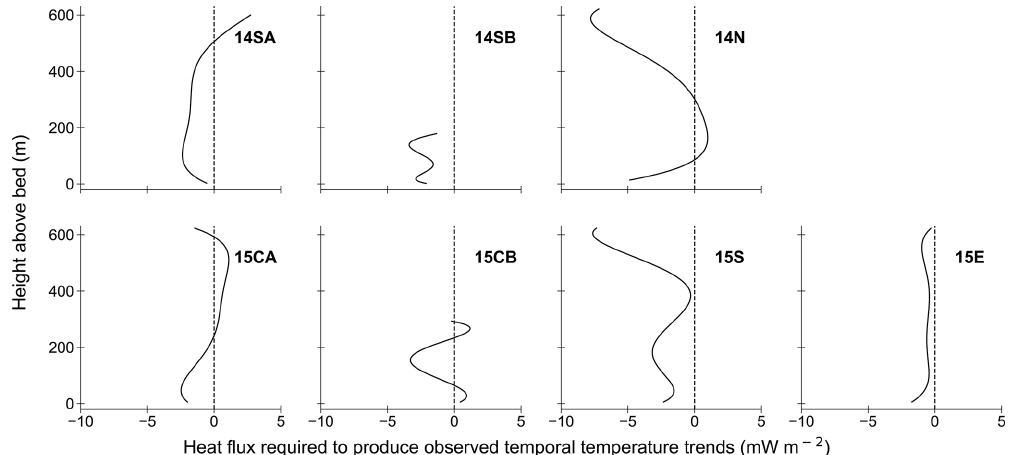
Figure 4. Additional heat fluxes required to maintain observed rates of temperature change if the collected static temperature profiles evolve through vertical thermal conduction over time. The dashed line indicates the switch between a required heat source or sink.